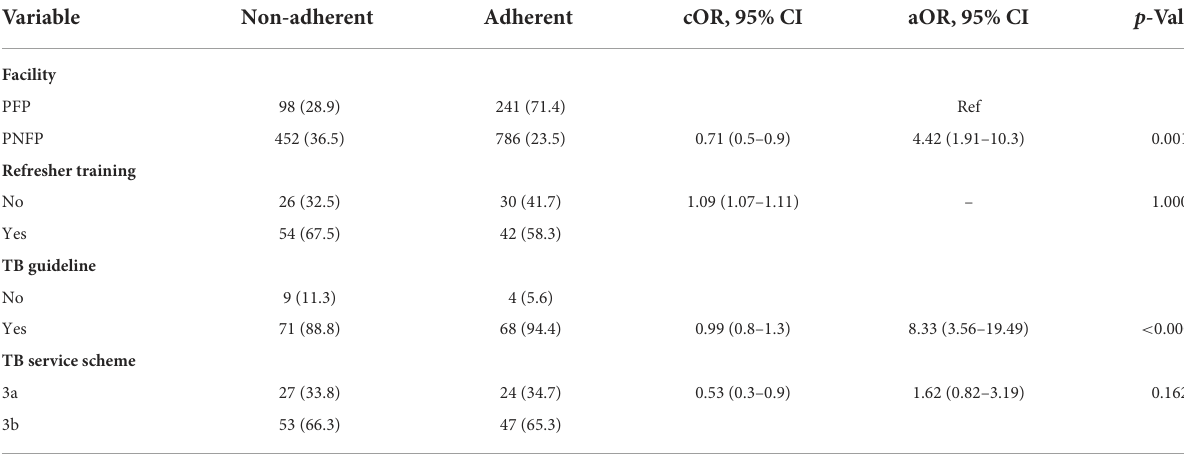
TABLE 4 Facility and DOTS provider correlates of adherence to National TB